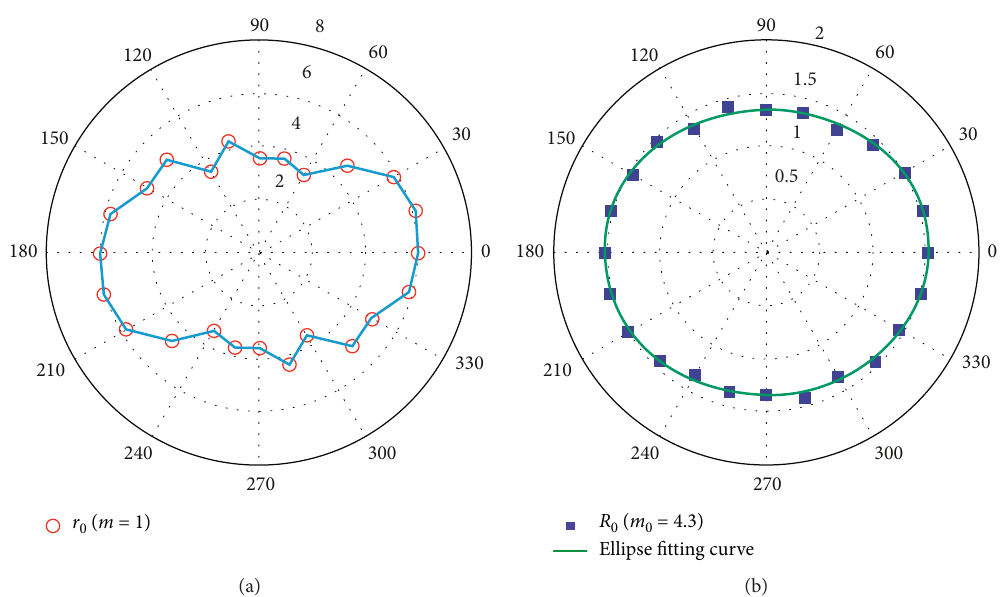
Figure 8: Polar plots of the original and processed JRC values and the ellipse fitting curves of the test samples in the length of 1000mm.